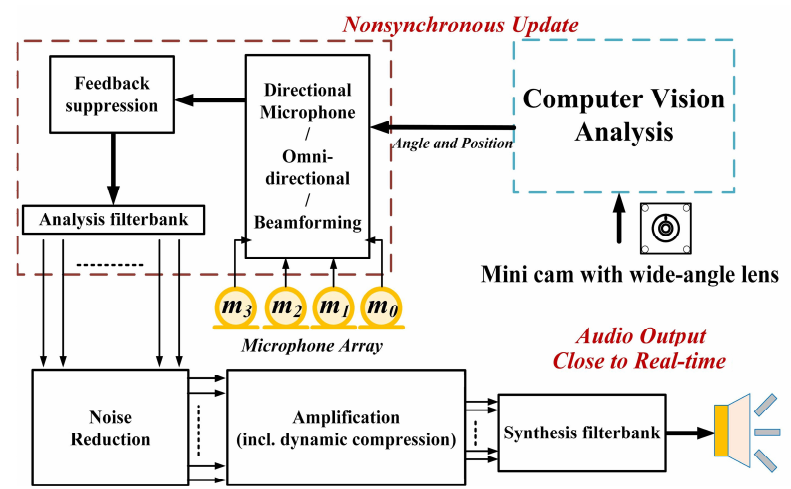
Figure 1. Signal processing of the proposed